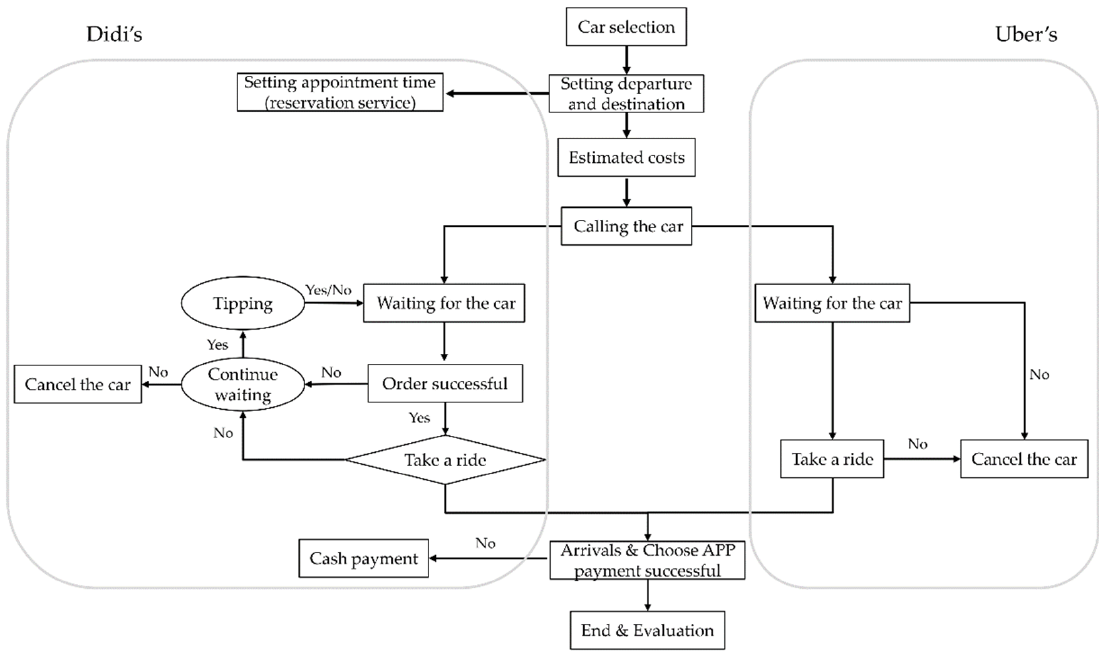
Figure 5. Service Flow Comparisons between DiDi and Uber.